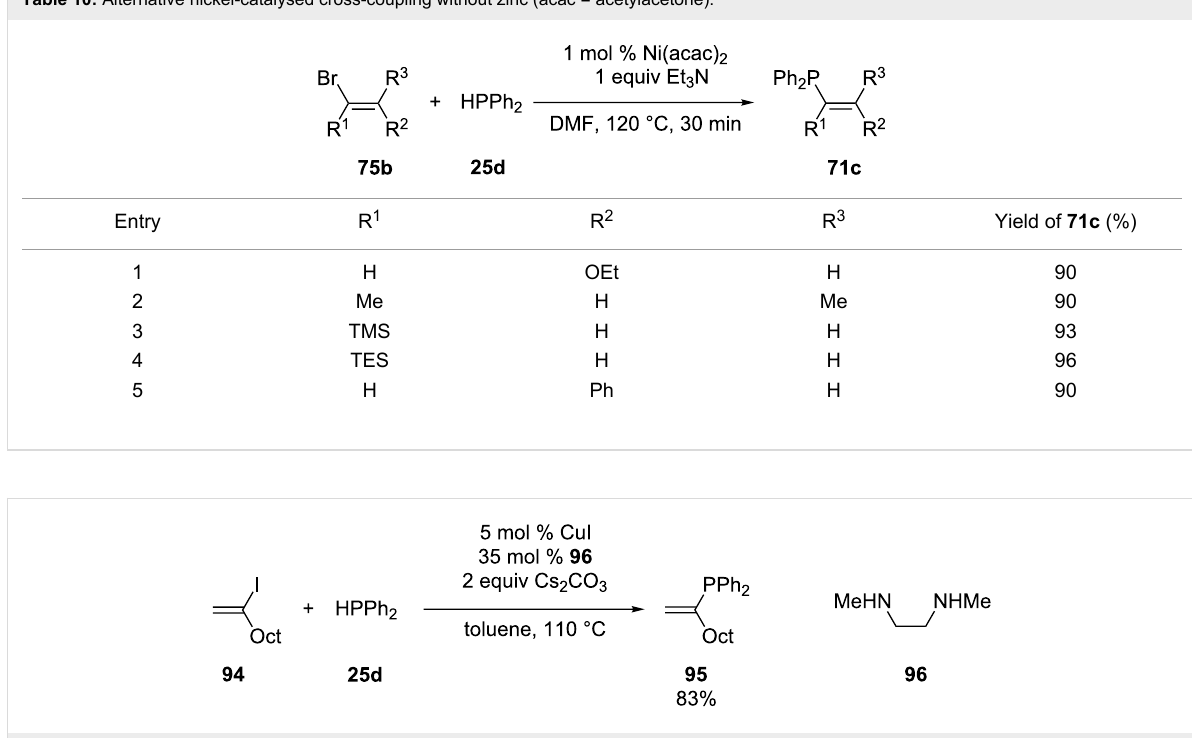
Table 10: Alternative nickel-catalysed cross-coupling without zinc (acac =